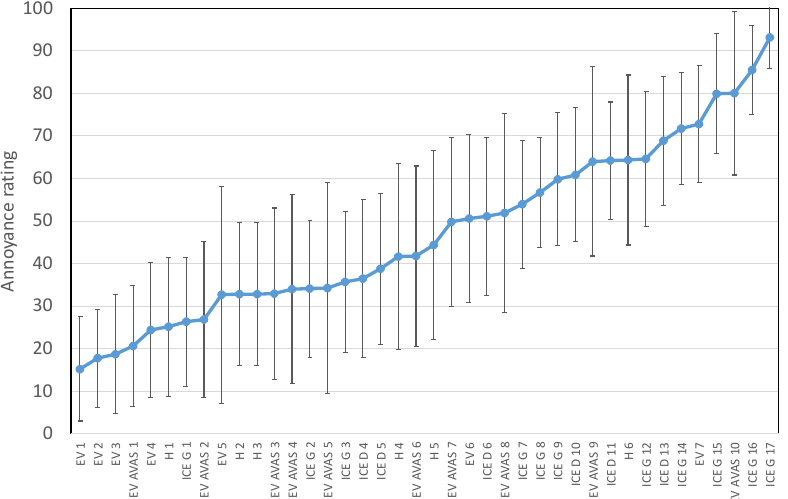
Figure 3. The annoyance ratings of various car pass-by noises. In the ratings, 100 means extremely annoying and 0 means not at all annoying. Abbreviations: EV: electric vehicle without a warning sound, EV AVAS: electric vehicle with a warning sound, ICE G: gasoline internal combustion engine vehicle, ICE D: diesel internal combustion engine vehicle, H: hybrid vehicle.